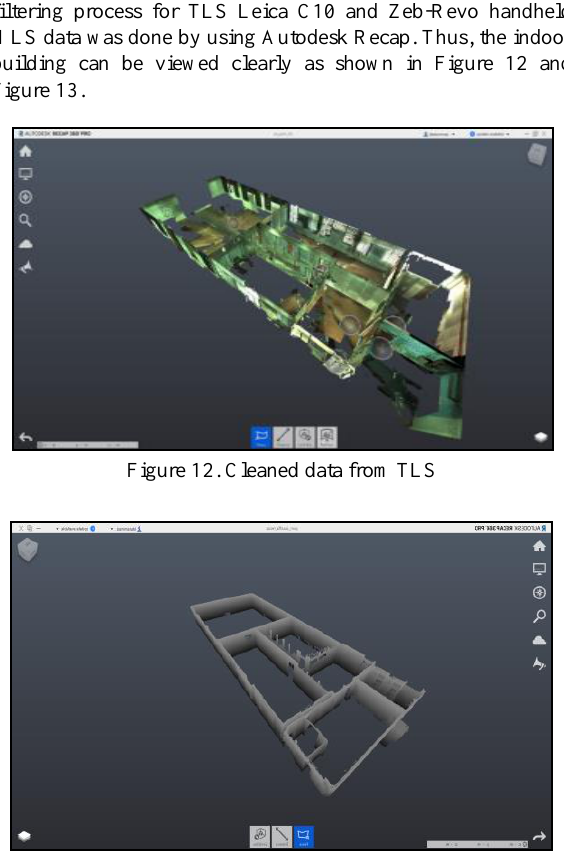
Figure 13. Cleaned data from MLS